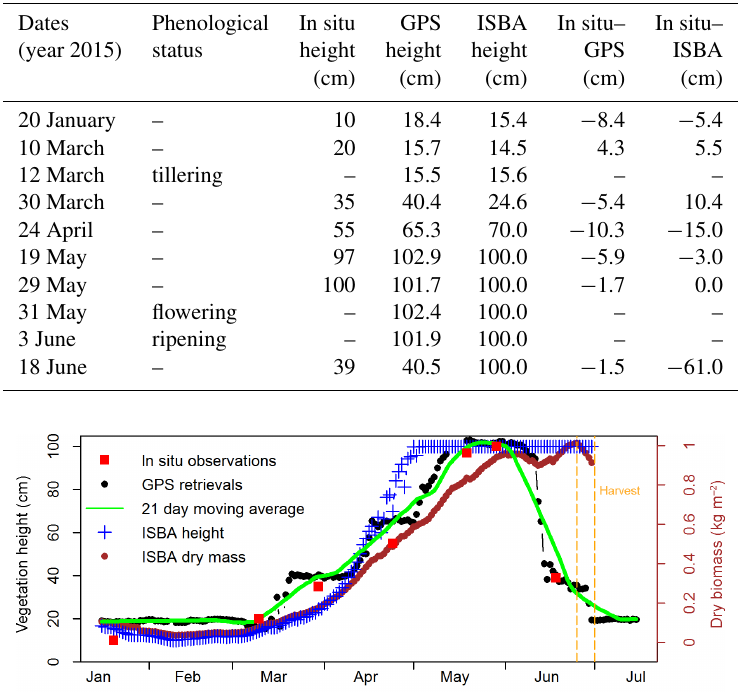
Table 3. Vegetation height retrievals from GPS and simulations from ISBA, and their relative deviations for each in situ height observation. The phenological statuses are derived from the GDD model.